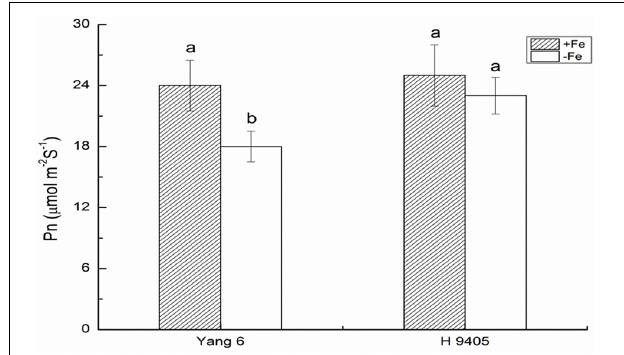
FIGURE 4 | Effects of iron deficiency on the photosynthetic rate on rice of different genotypes. Data are presented as means ± SE of three biological replicates. Significant differences among treatments are indicated by different letters as determined by Duncan’s test ( P < 0.05).